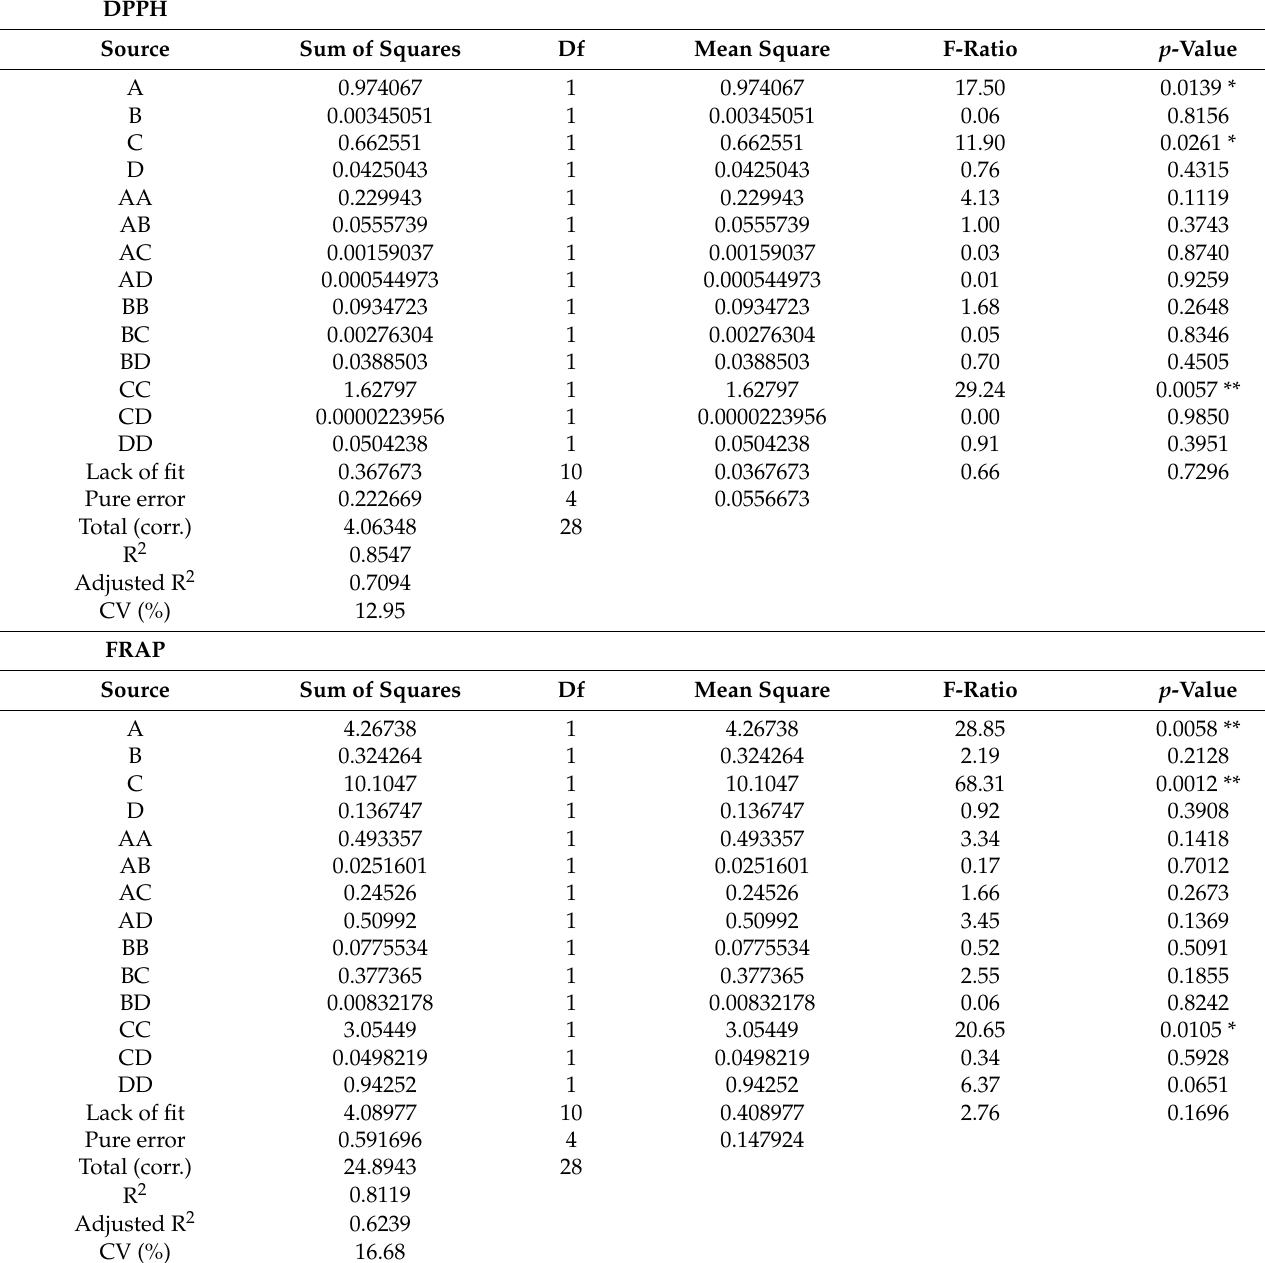
Table 2. ANOVA results for DPPH, FRAP, and TPC